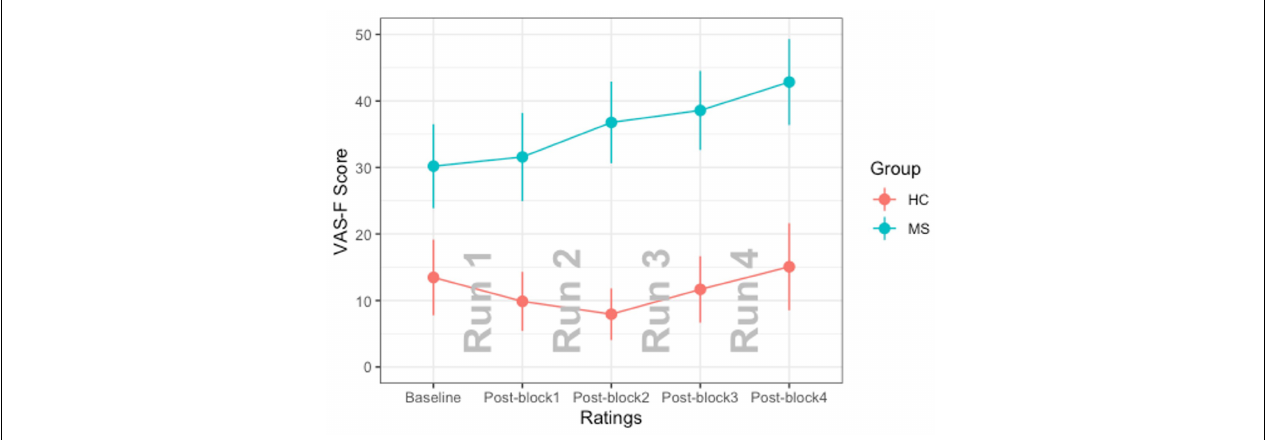
FIGURE 1 | The interaction of Group × Rating is shown. The MS group is plotted in blue and the HC group is plotted in red. Error bars represent standard errors of the